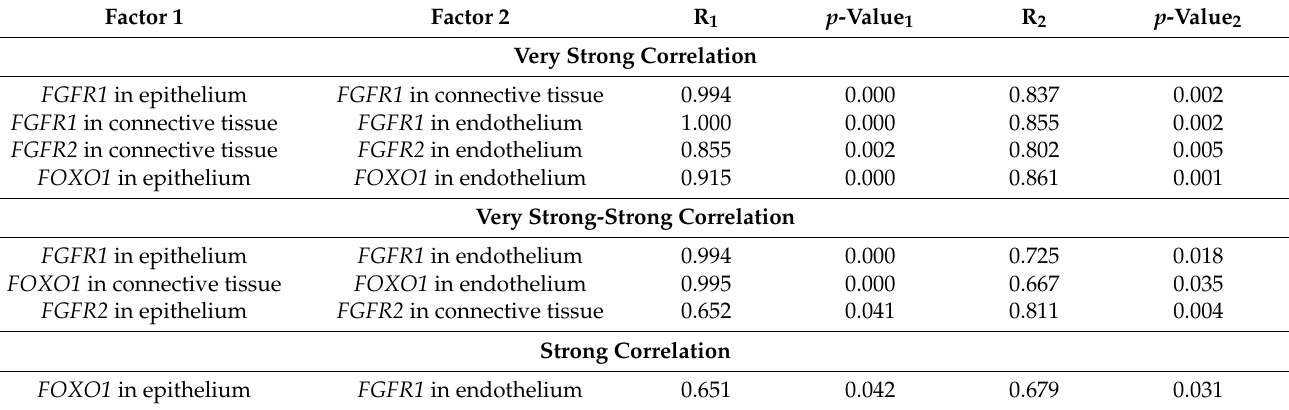
Table 4. Statistically significant correlations between factors in patients’ lip and palatine tissue samples based on Spearman’s correlation